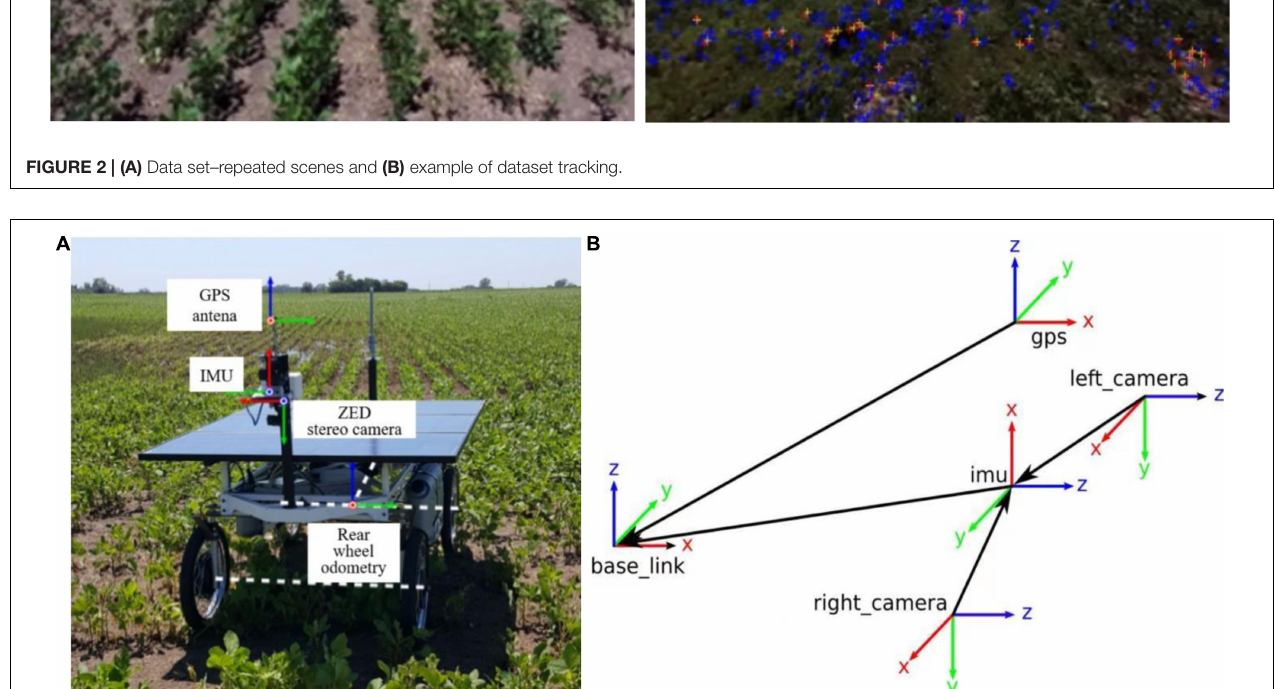
FIGURE 3 | (A) Weeding mobile robot equipped with sensors and (B) dataset coordinate system